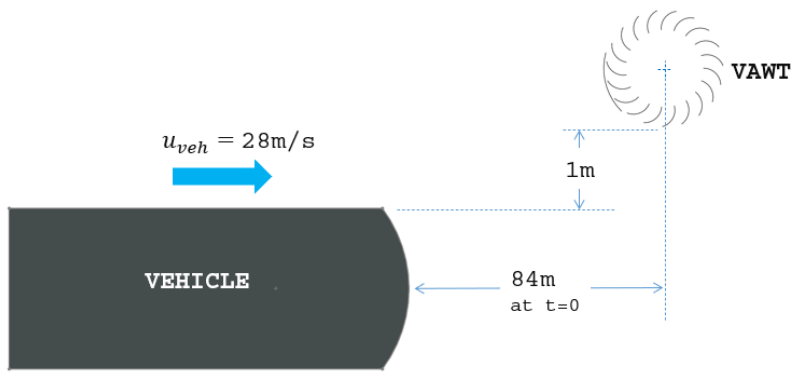
Figure 1. Coordinates of the vehicle and